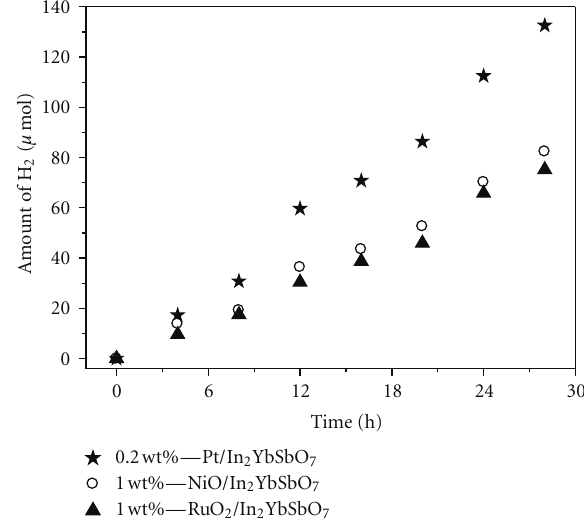
Figure 6: Photocatalytic H 2 evolution from aqueous methanol solution with Y 2 YbSbO 7 , In 2 YbSbO 7 , or Gd 2 YbSbO 7 as catalyst under visible light irradiation (no cut-o ff filter, 0.5g 0.1wt% Pt- loaded powder sample, 50 mL CH 3 OH, 200 mL pure water). Light source: 300 W Xe lamp.